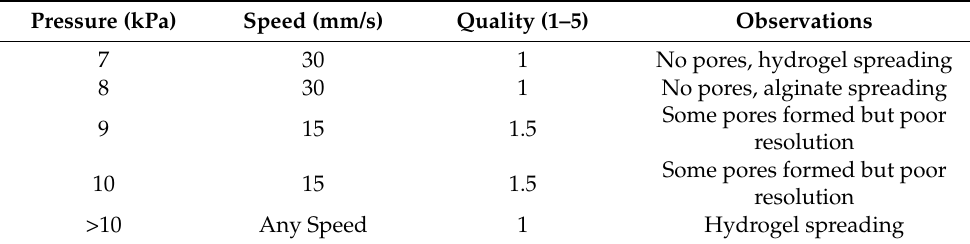
Table 2. Observations of the quality of the A4-G6 bioprinted scaffold based on different printing parameters. The quality (print resolution) of the constructs were rated on a scale from 1 to 5, with 1 being the lowest resolution and 5 being the highest.